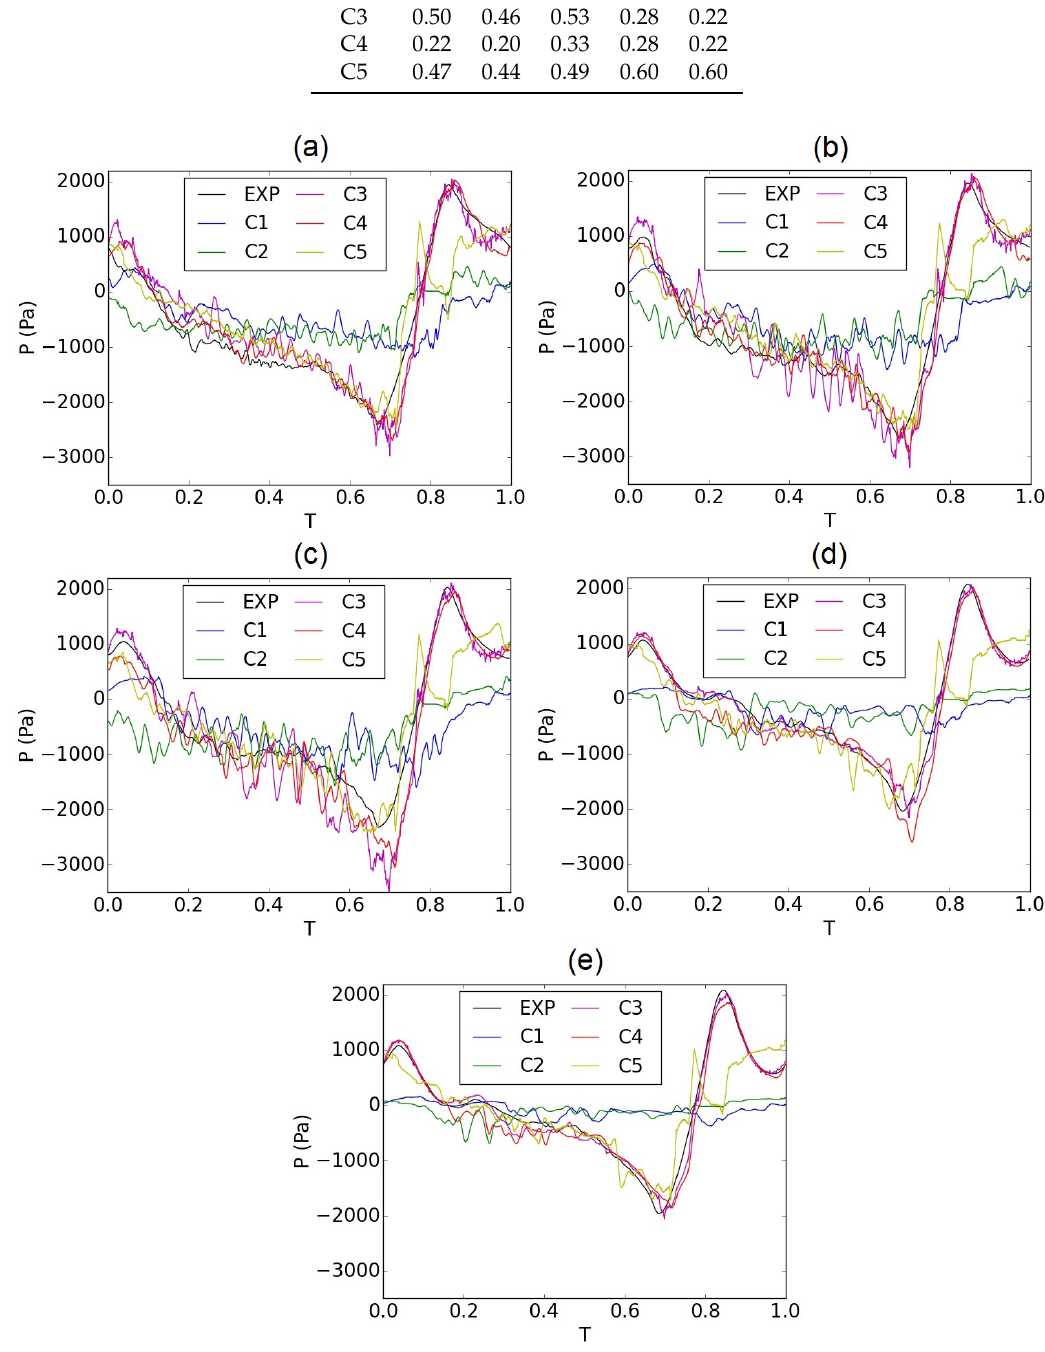
Figure 5. Pressure evolution for a cycle of oscillation at the pressure probes P1–P5 (parts ( a – e )) in the supraglottal region introduced in Figure 1 for the experimental larynx model and the numerical simulation cases C1–C5 introduced in Table